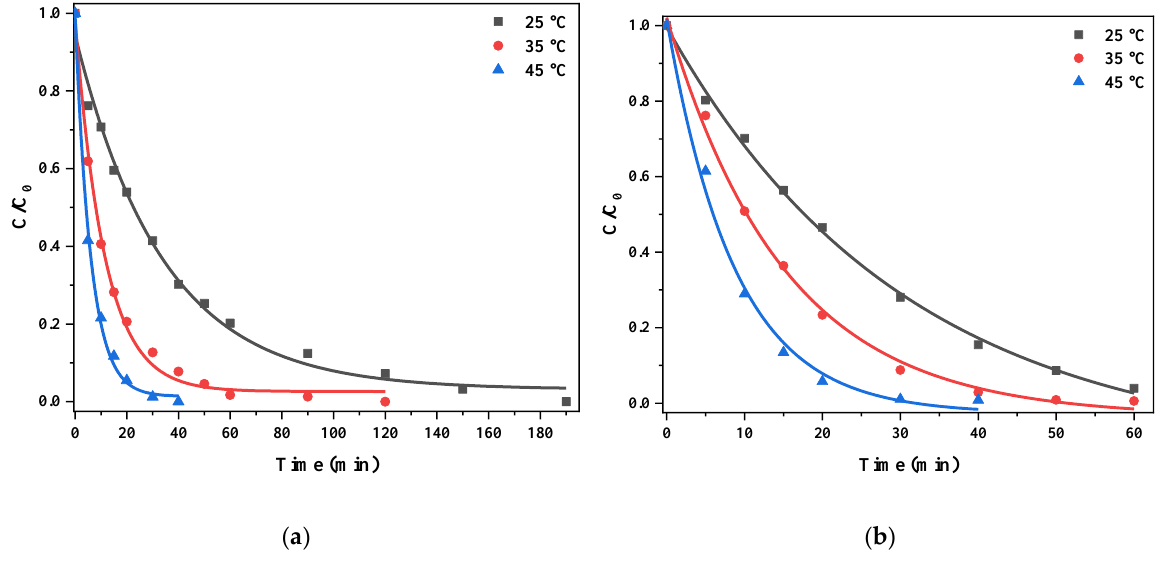
Figure 5. Phenolic degradation efficiency in catalytic oxidation using manganese oxide catalysts. Reaction condition: phenol concentration = 25 ppm, catalyst = 0.4 g/L, PMS = 2 g/L, and t = 25 °C.